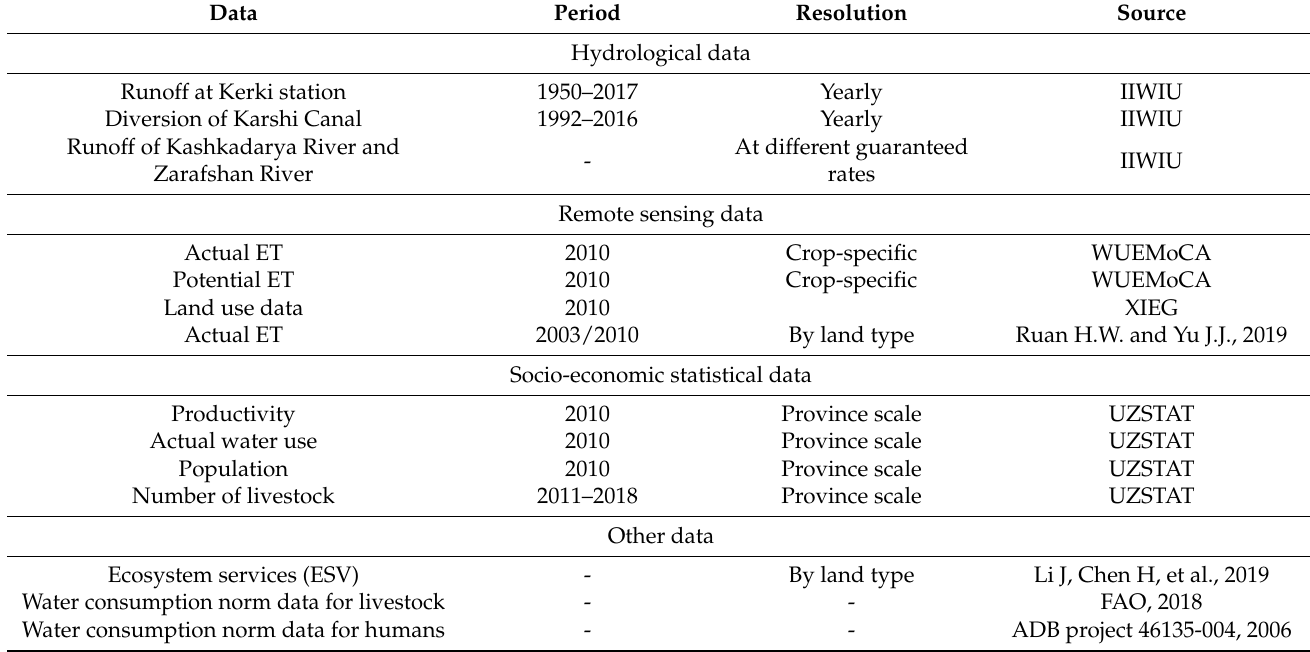
Table 1. List of data